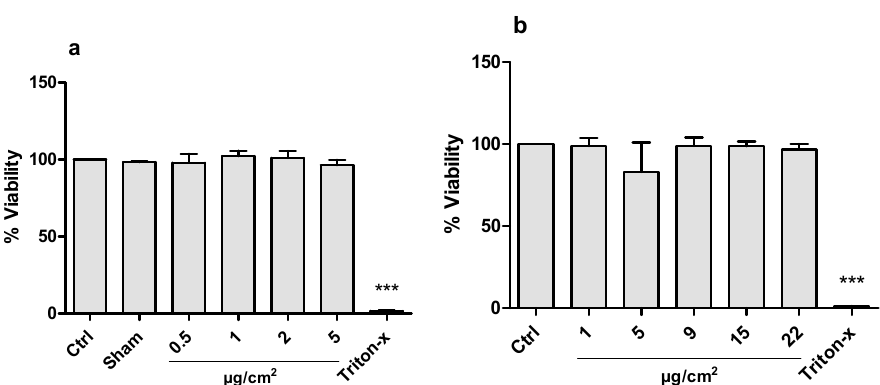
Figure 3. Cell viability analyzed by Alamar blue assay in co-cultured A549 and THP-1 cells exposed to CeO 2 NPs for 24 h in air-liquid interface (ALI) ( a ) or in submerged ( b ) cell culture. Triton-x (0.1%) was used as positive control. Data is presented as % of the control value (Ctrl), and bars show mean ± SD. For ALI, clean air exposure (Sham) was used as additional control. Significant results as compared to the control are marked with asterisks (*** for p < 0.001).